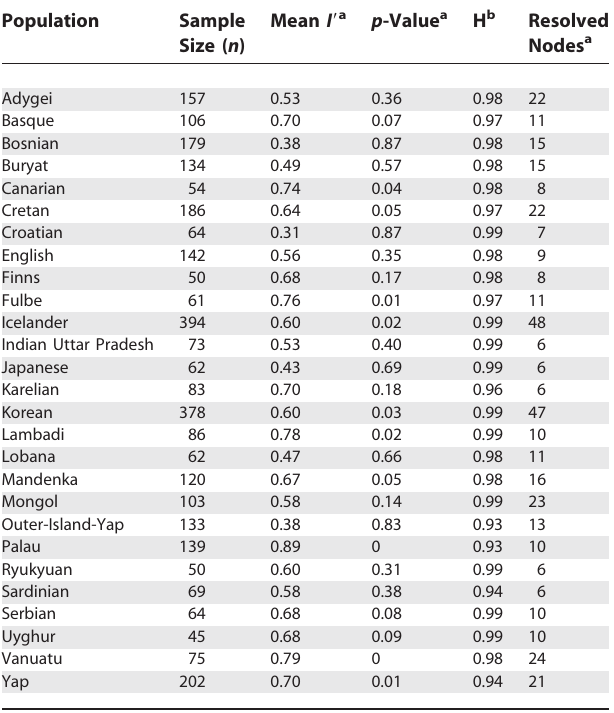
Table 9. mtDNA Genealogy Imbalance for FPPs Population Sample Mean I 9 Size ( n )